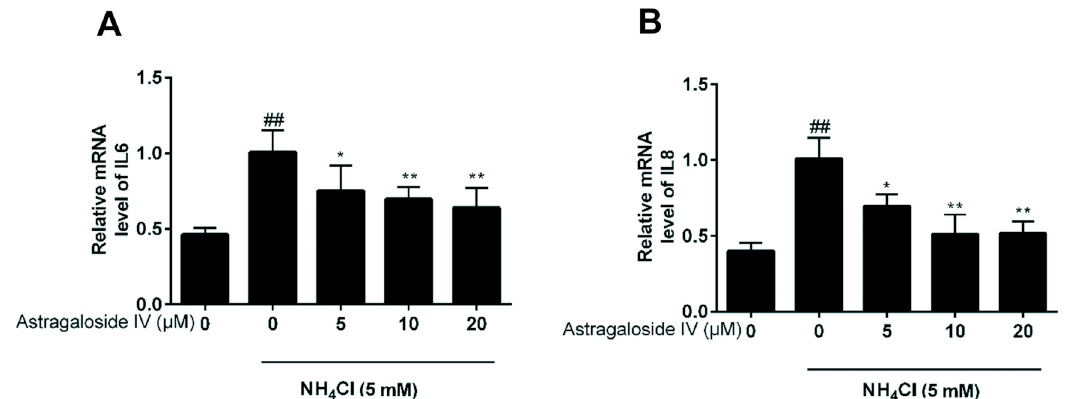
Figure 4. Effects of astragaloside IV on mRNA expression of inflammatory factors ( IL-6 and IL-8 ) induced by ammonia in MAC-T cells. The mRNA expressions of IL-6 ( A ) and IL-8 ( B ) were analyzed using quantitative real-time PCR. Data are represented as mean ± SD from three independent experiments. The data are shown as mean ± SD. n = 4. *, p < 0.05; **, p < 0.01. ## indicates a significant difference from untreated cells at p < 0.01.